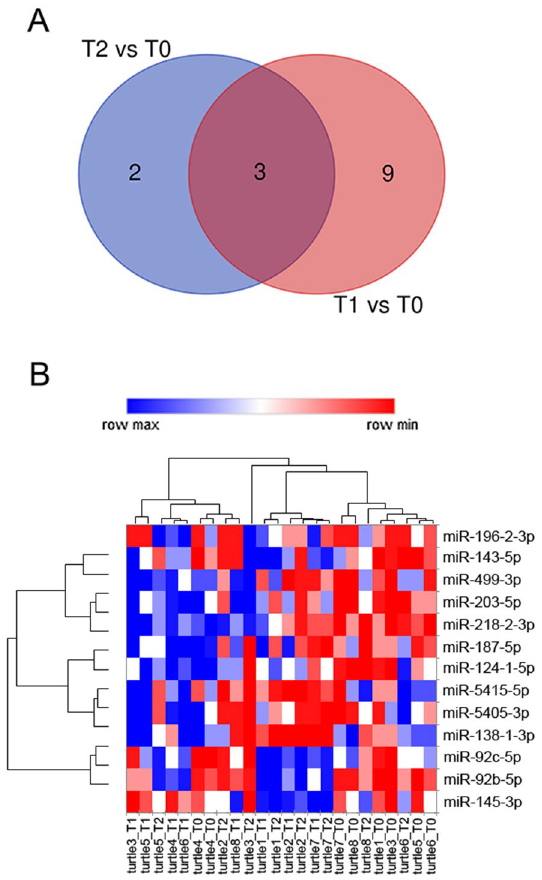
Figure 1. Identification of DE-miRNAs on plasma of turtle comparing pre-surgery (T0) and 2.5 h (T1) and 36 h (T2) post-surgery. ( A ) Venn diagram showing DE- miRNAs; ( B ) heat-map